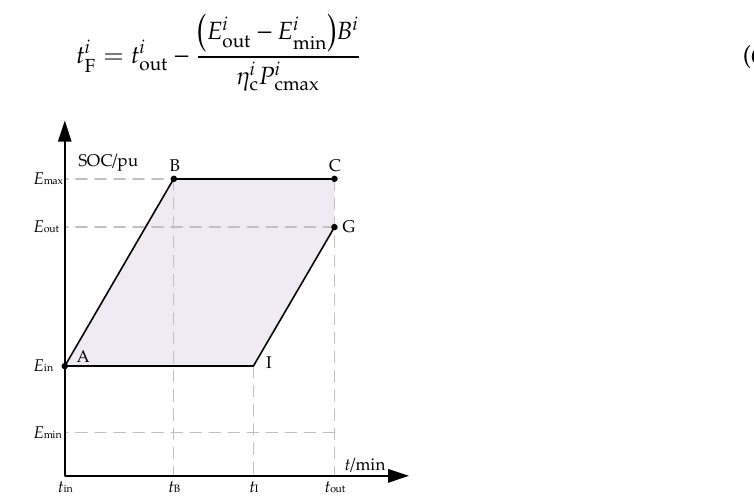
Figure 2. The charging/discharging energy boundary model of a controllable electric vehicle (EV) in grid-to-vehicle (G2V).